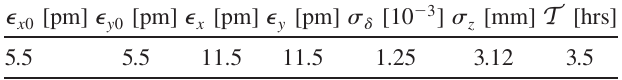
FIG. 13. Emittance (cid:6) nominal bunch current (black) and at zero